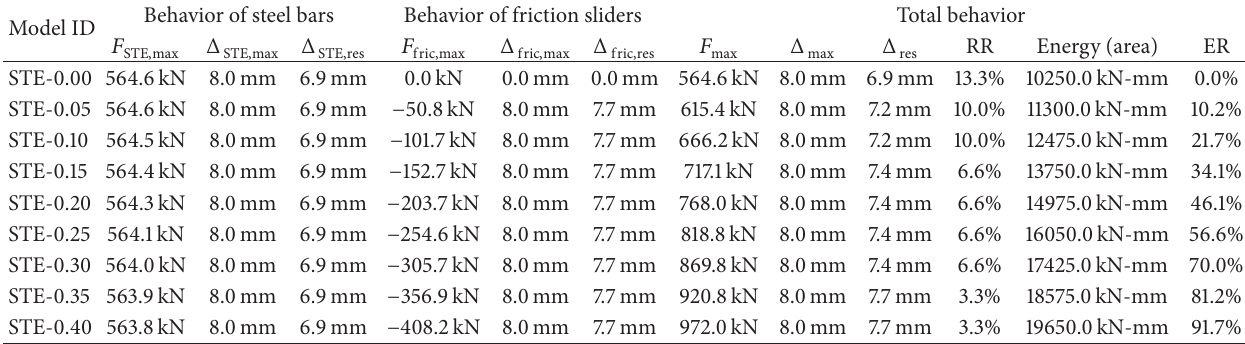
Table 1: Summarized analysis results for the steel bearing systems.